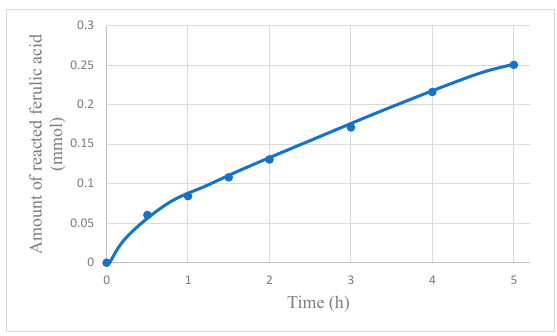
Figure 1. The amount of reacted ferulic acid (FA) vs. time, t, in the case of photocatalysis without dialysis.